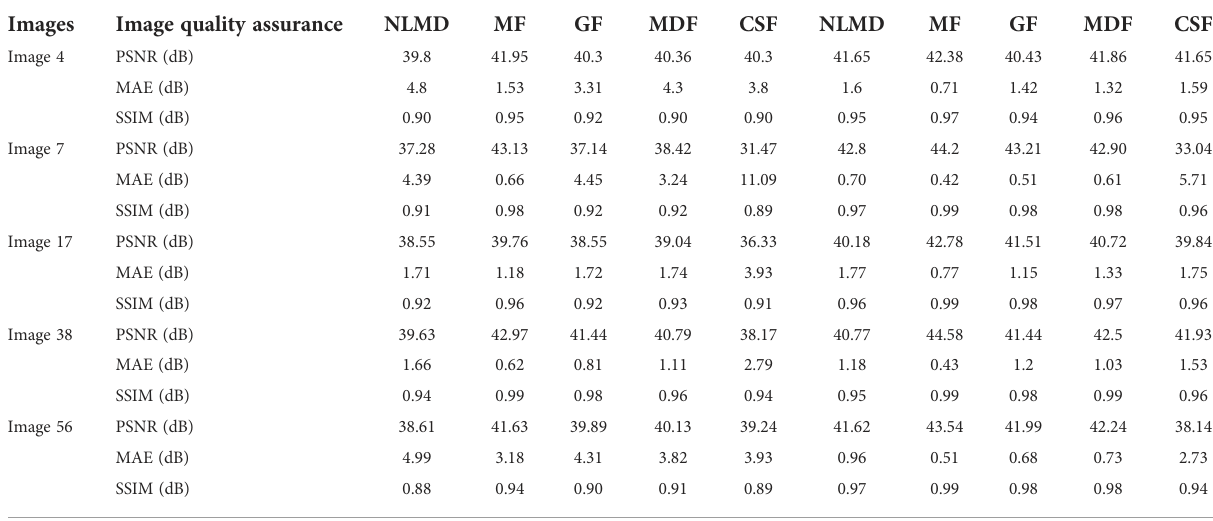
TABLE 2 Assessments on PSNR, MAE, and SSIM values for fi ve different images of HE and PLT. HE